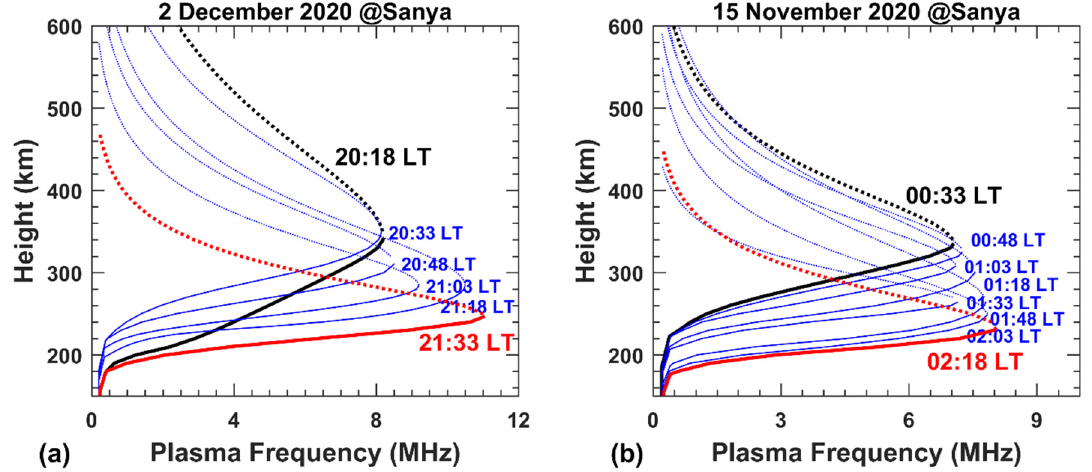
Figure 9. Temporal evolution of electron density profiles derived from ionograms recorded at Sanya (109.6° E, 18.3° N) during the electron density enhancement phase on ( a ) 2 December 2020 and ( b ) 15 November 2020. The dotted lines represent topside profiles.